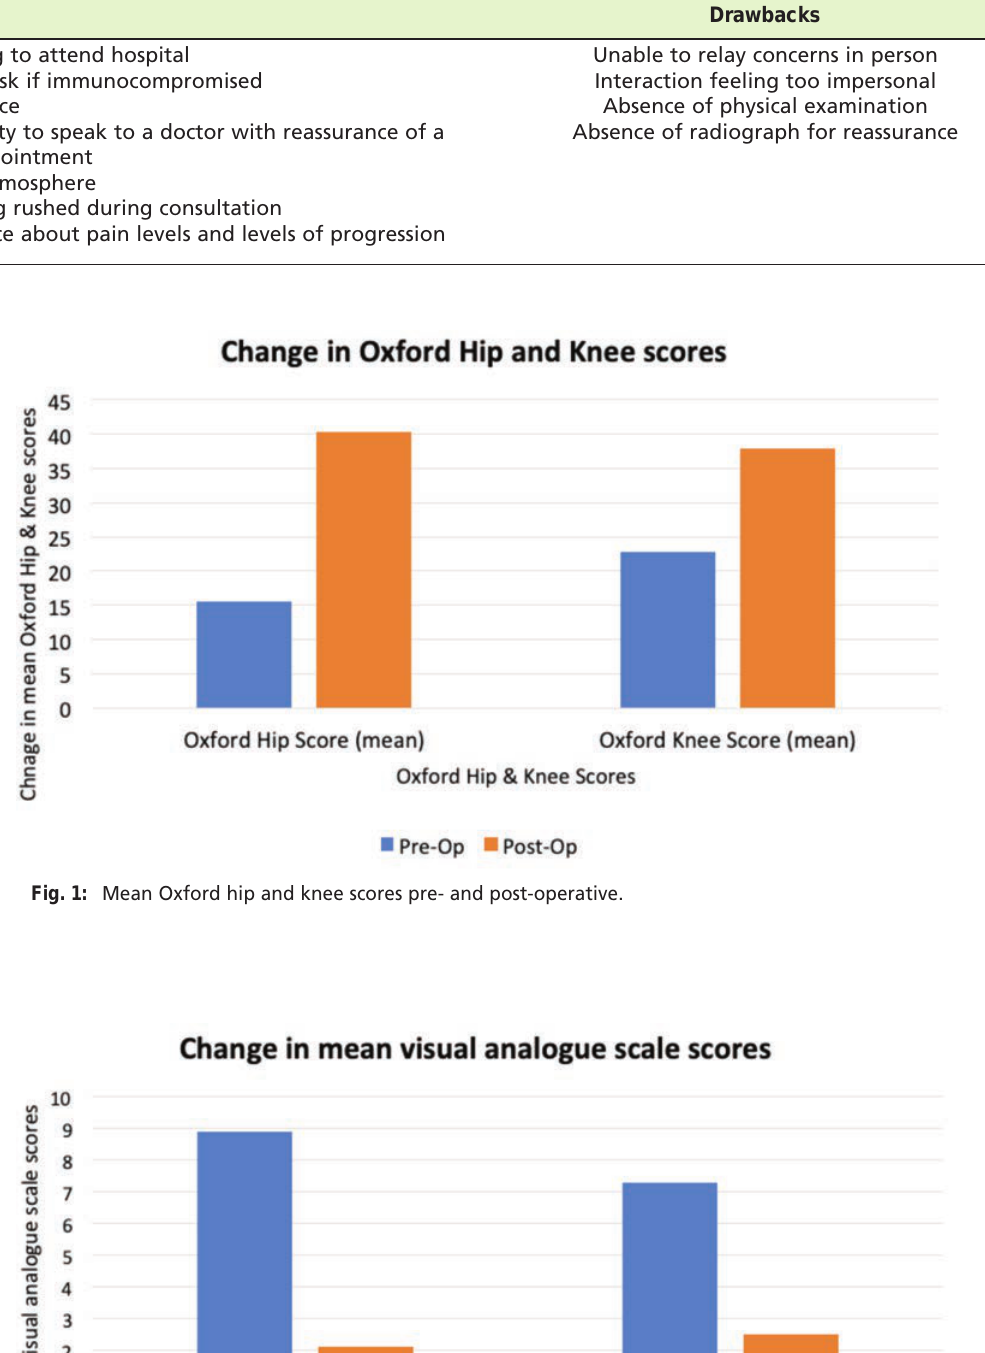
Qualitative patient comments regarding virtual arthroplasty clinic experience Table III: